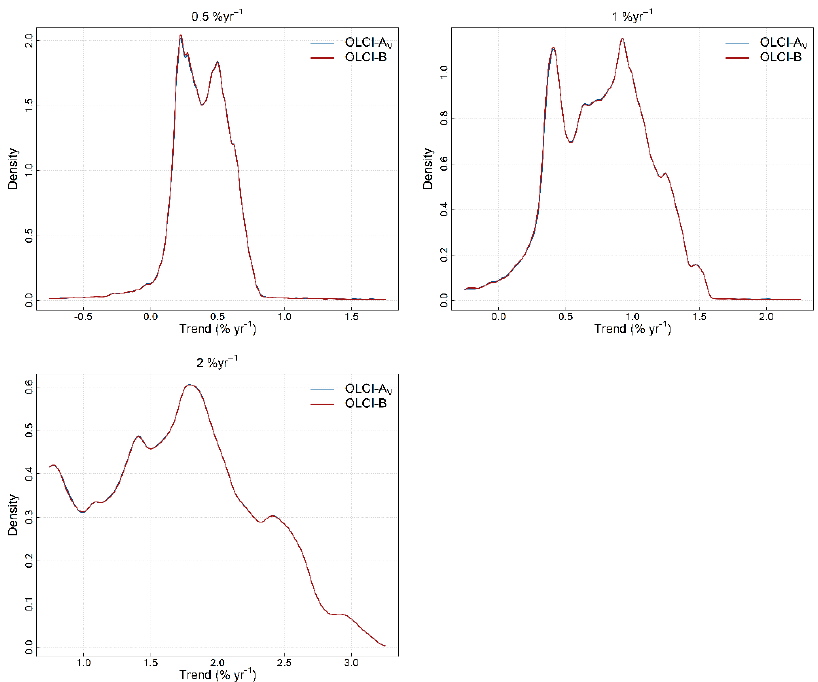
Figure A3. Histogram of all chl- a trends estimated in all 1° grid cells and all bootstraps for OLCI-A-Vicarious and OLCI-B. This shows that OLCI-A-Vicarious and OLCI-B both show very similar distributions of chl- a trends, except that OLCI-A has slightly smaller variance, which applies to all input trends.